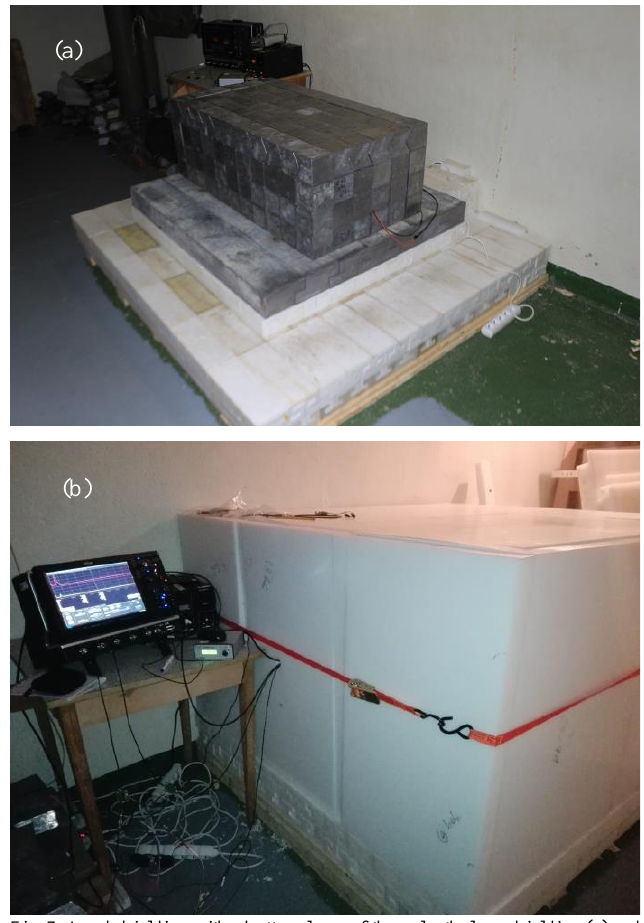
Fig. 7. Lead shielding with a bottom layer of the polyethylene shielding (a) and complete lead and polyethylene shielding (b).